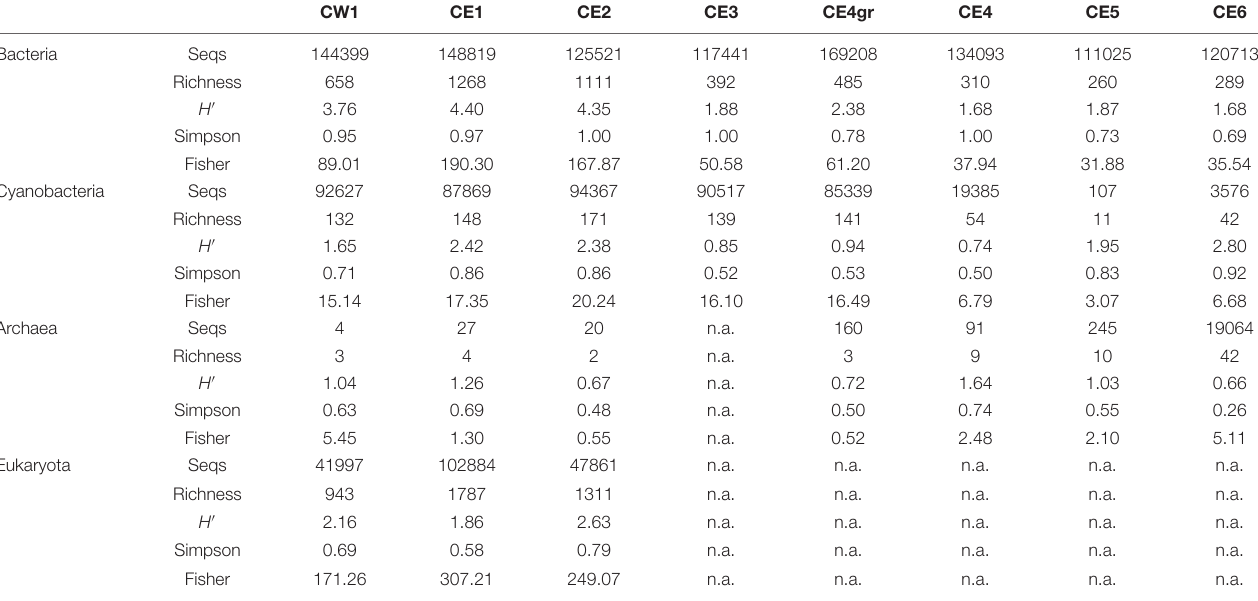
“n.a.” indicates not